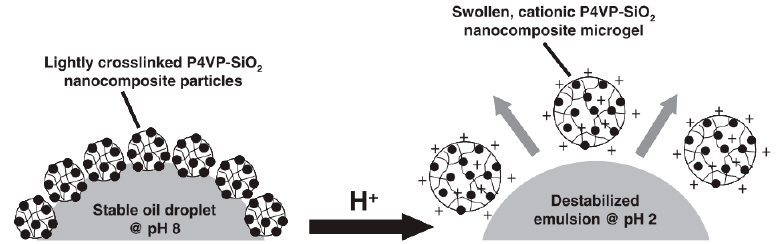
Figure 13. Schematic representation of pH-induced demulsification of an oil-in-water emulsion using lightly cross-linked poly(4-vinylpyridine)/silica (P4VP/SiO 2 ) nanocomposites as particulate emulsifiers. Reprinted with permission from [113]. Copyright 2005, WILEY-VCH Verlag GmbH & Co. KGaA, Weinheim, Germany.